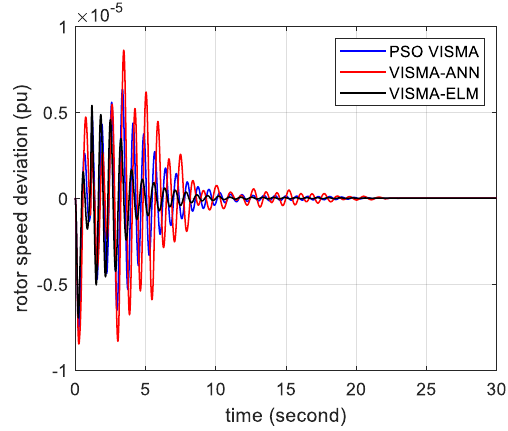
Figure 16. Rotor speed responses of G4 under different methods.